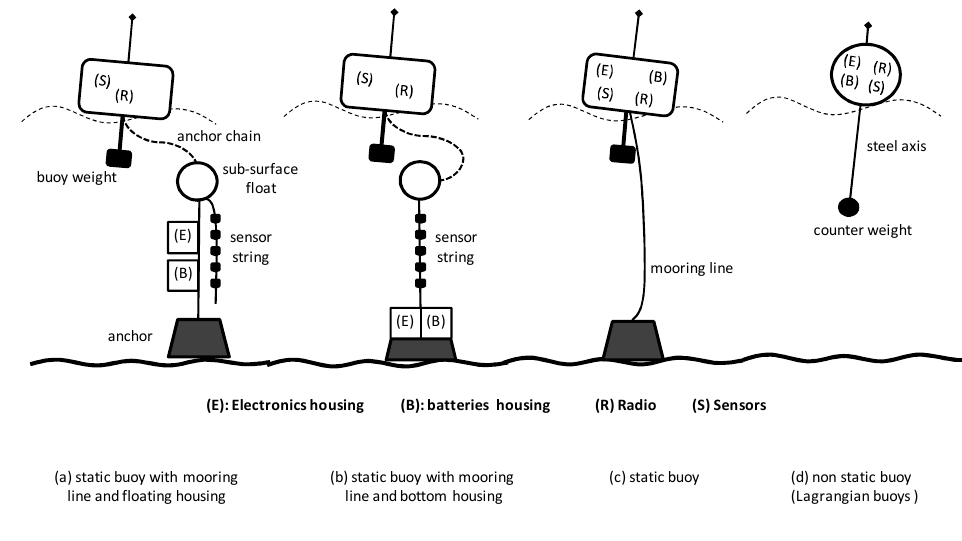
Figure 6. Most representative configurations of buoys used in